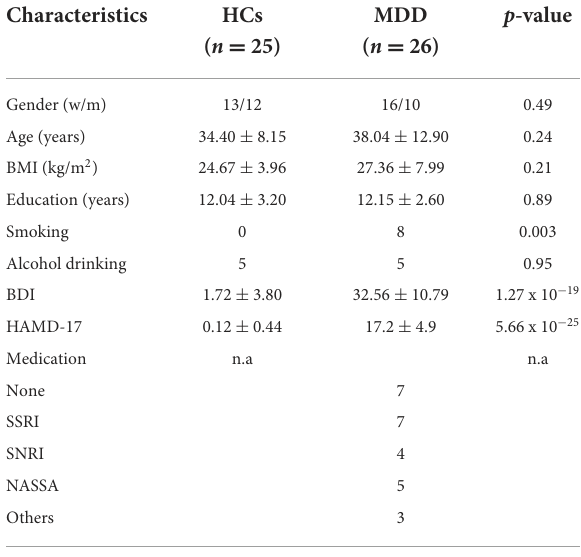
TABLE 1 Demographical and clinical characteristics of patients with MDD and HCs.